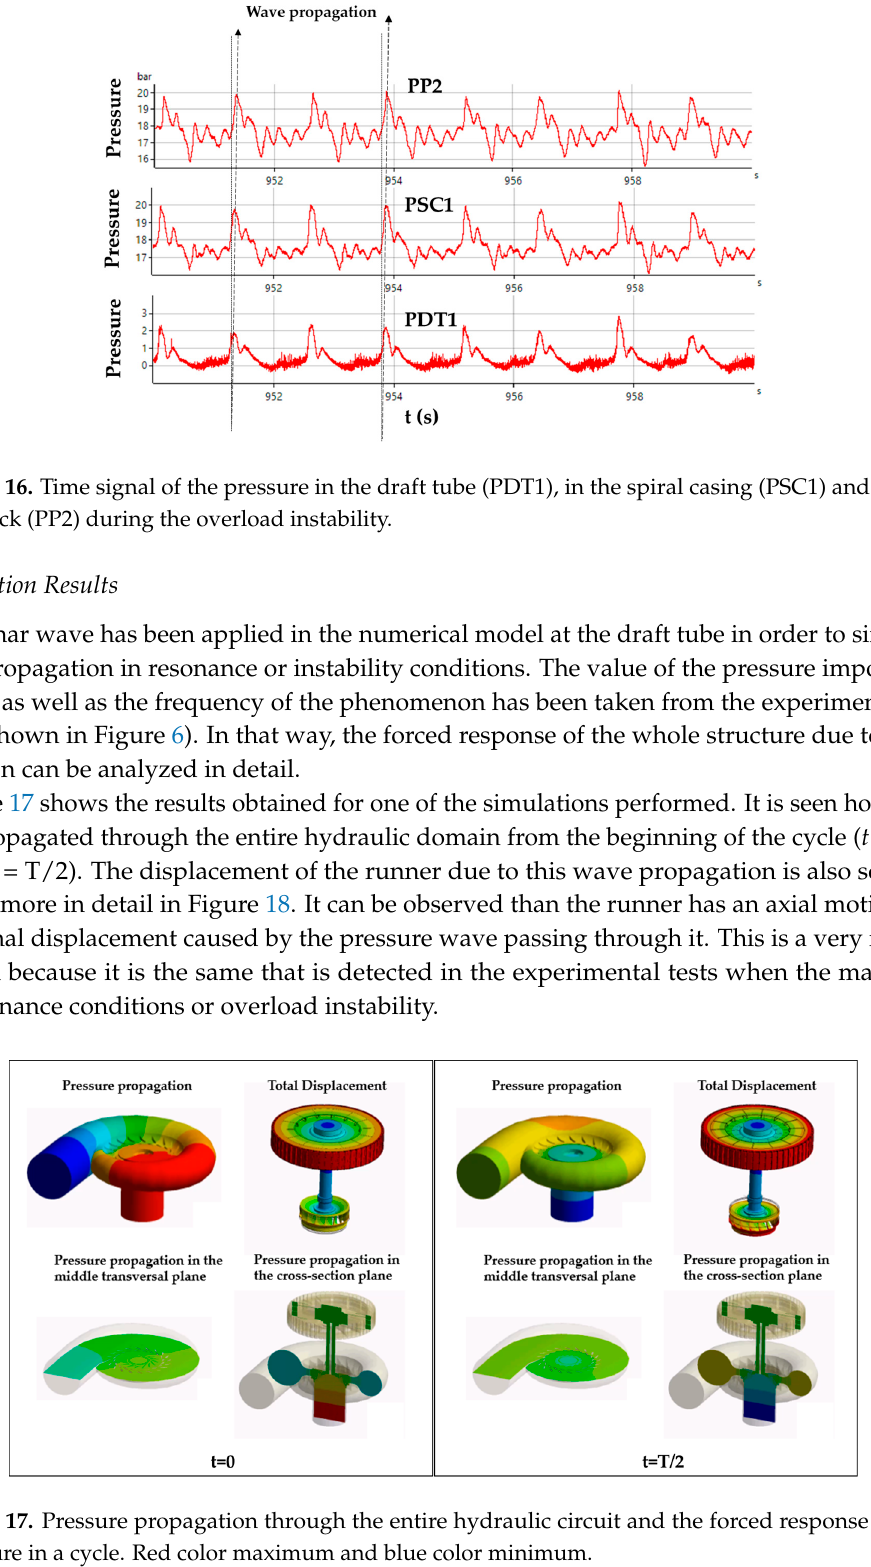
Figure 17. Pressure propagation through the entire hydraulic circuit and the forced response of the structure in a cycle. Red color maximum and blue color minimum.